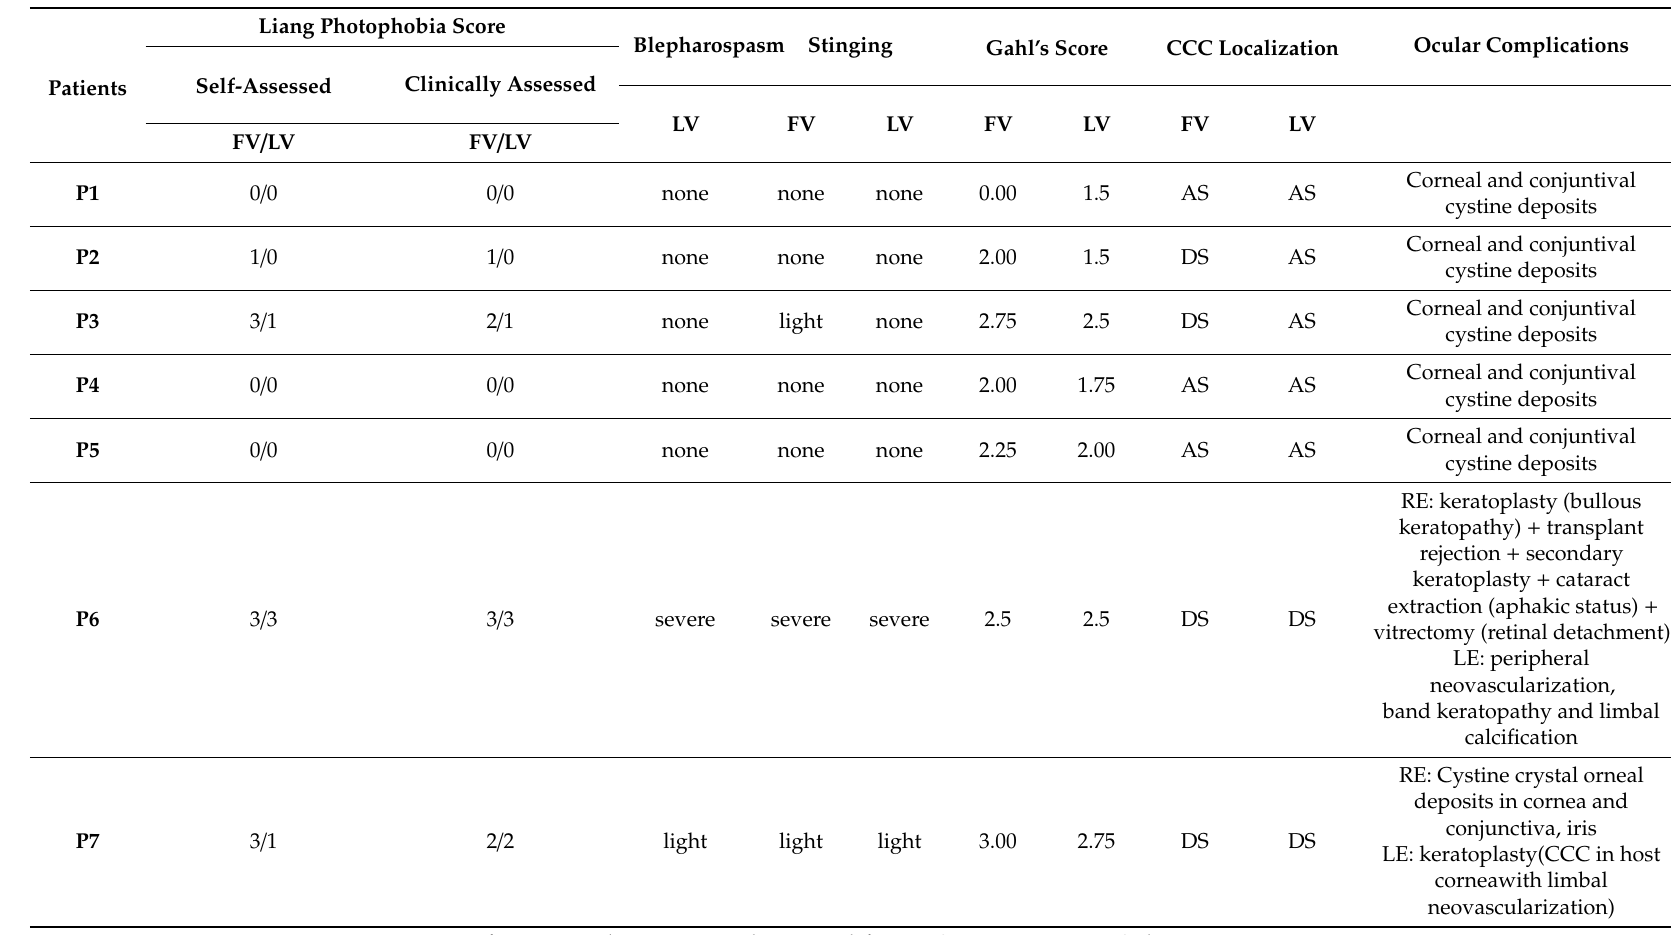
Table 3. Self- and clinically-assessed photophobia grading based on the Liang photophobia scaling system and ocular complaints reported by examined patients. Assessment of corneal cystine crystals (CCC) using Gahl’s score (CCCS) and their locations assessed with anterior segment OCT (AS-OCT). Ocular complications (anterior and posterior segment)